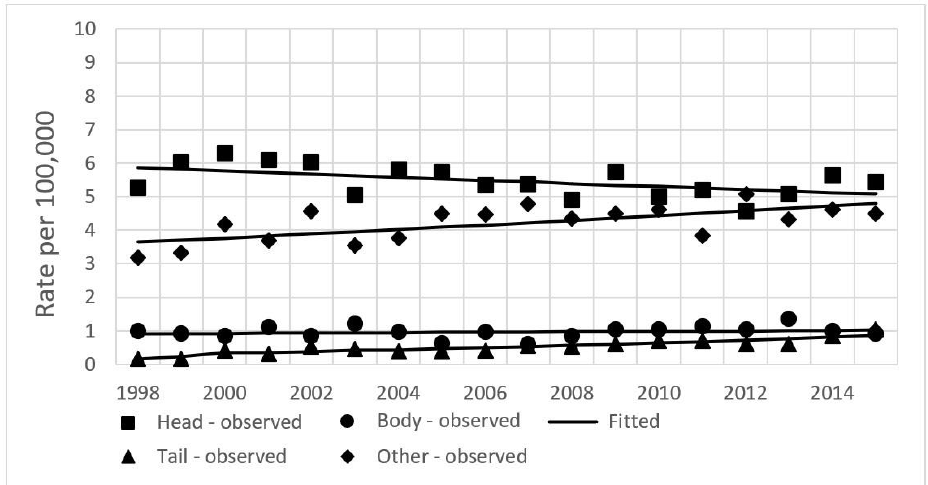
Figure 5. Age-standardized incidence rates of pancreatic cancer by subsite in Lithuania from 1998– 2015. Both sexes.